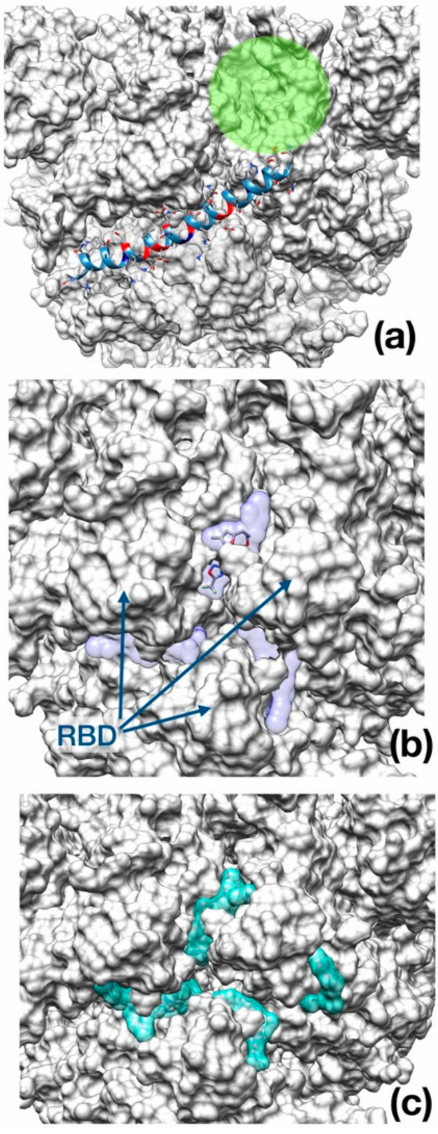
Figure 5. Best binding pose found with AutoDock Vina docking algorithm. ( a ) Enfuvirtide (shown in ribbon representation); ( b ) Umifenovir; ( c ) Pleconaril. The channel within the trimeric cap, is reported as a green circle. In panel ( b ) and ( c ), the transparent surface area indicates the localization of each inhibitor in the best five docking poses for Umifenovir (purple) and Pleconavir (green). The receptor-binding domains (RBD) are indicated by arrows in the middle panel as a